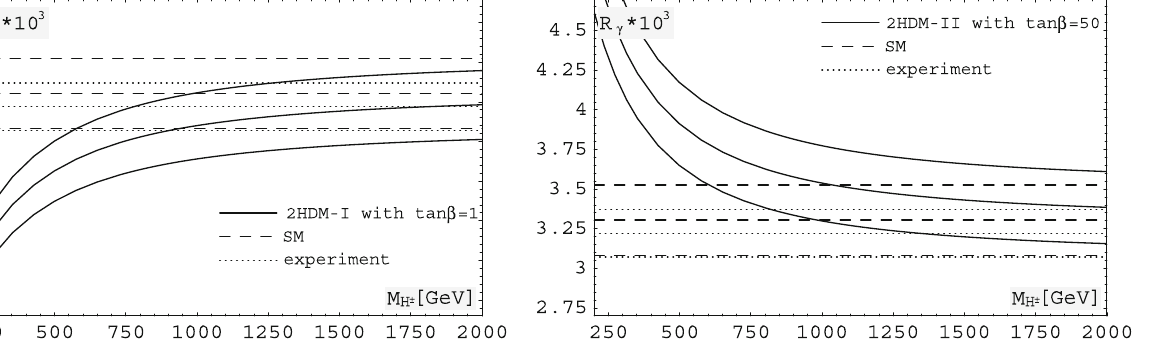
by ± 1 σ . Solid and dashed curves correspond to the 2HDM and SM predictions, respectively. Dotted lines show the experimental average R exp γ = ( 3 . 22 ± 0 . 15 ) × 10 − 3 (see Sect.